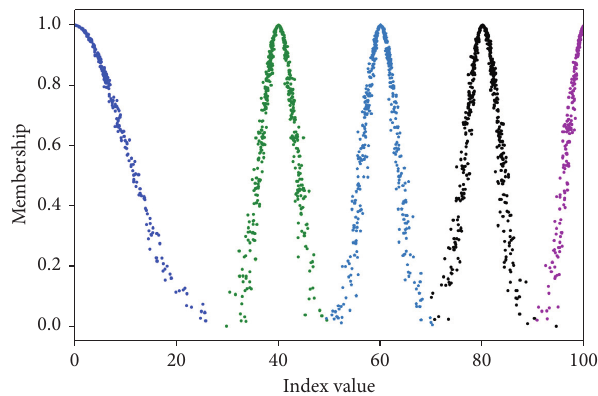
Figure 3: Standard cloud map of risks evaluation grade thresholds.